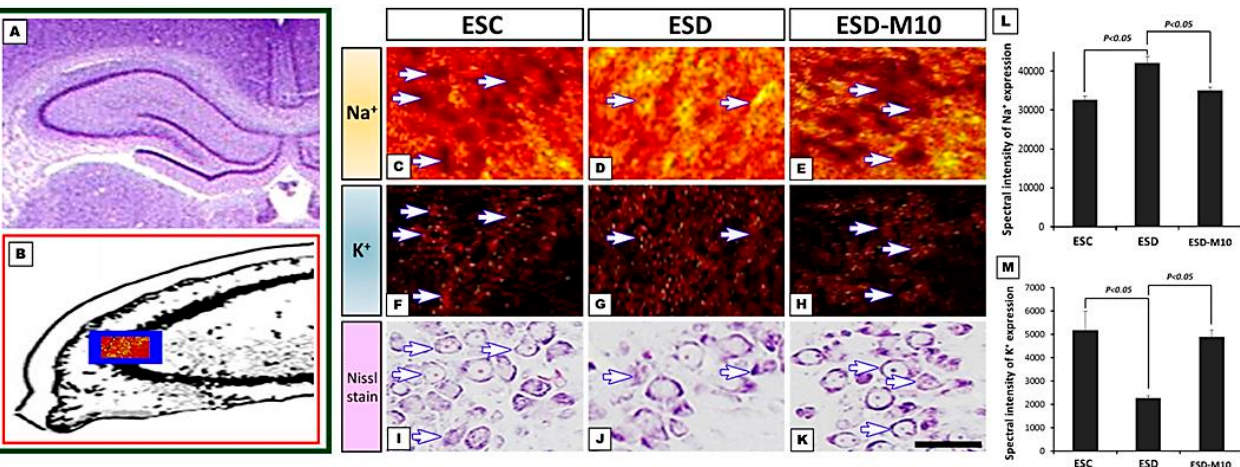
Figure 3. Photomicrograph ( A ), schematic diagram ( B ), positive ion images ( C – K ), and histograms ( L , M ) showed both Na + and K + expression in the hippocampus of ESC ( C , F , I ), ESD ( D , G , J ), and ESD with melatonin treatment ( E , H , K ) groups. Note that in ESC group, most of the hippocampal neurons (arrows in C ) were devoid of Na + signal in the intracellular portions. On the contrary, intense K + signal was kept in the intracellular part of hippocampal neurons (arrows in F ). However, following ESD, strong Na + signal was accumulated in the intracellular portion of some hippocampal neurons (arrows in D ), suggesting an impairment of Na + pump was resulted from ESD. Nevertheless, after ESD and treated with melatonin, the distribution pattern of both Na + and K + was restored to nearly normal profile in which no significant Na + signal was detected in the intracellular portion of hippocampal neurons (arrows in E ). Quantitative data of the spectral intensity corresponded well the imaging findings ( L , M ). The blue box in ( B ) showed the detecting region of the ionic image. Scale bars: 50 μ m.